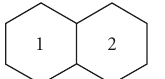
Figure 1: The two-cell